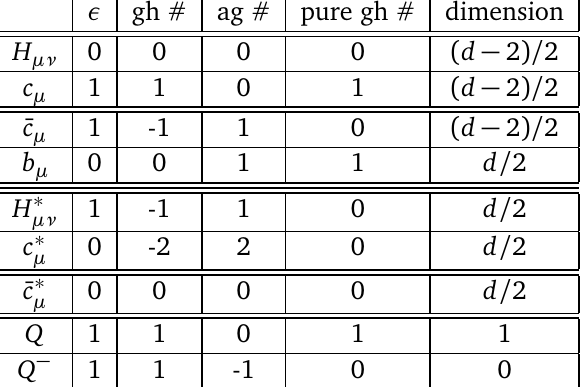
Table 1: The various Abelian charges (a.k.a. gradings) carried by the fields and oper- ators. ε is the Grassmann grading, being 1 ( 0 ) if the object is fermionic (bosonic). gh # is the ghost number, ag # the antighost / antifield number, pure gh # = gh # + ag #, and dimension is the engineering dimension. The first two rows are the minimi- mal set of fields, the next two make it up to the non-minimal set, then the ensuing two rows are the minimal set of antifields, and ¯ c ∗ is needed for the non-minimal set. µ Finally, the charges are determined in order to ensure that Q and Q − can also be assigned definite charges.